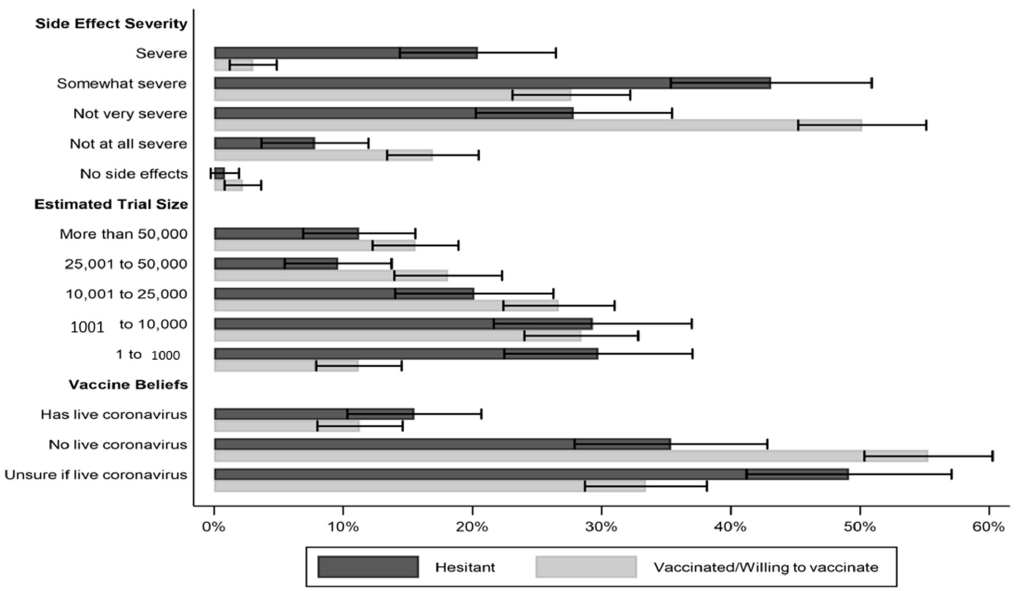
Figure 1. US adults’ perceptions of side effect severity, clinical trial size, and presence of live coronavirus in COVID-19 vaccines by vaccination status/hesitancy. Note: I-bars present 95% CIs.